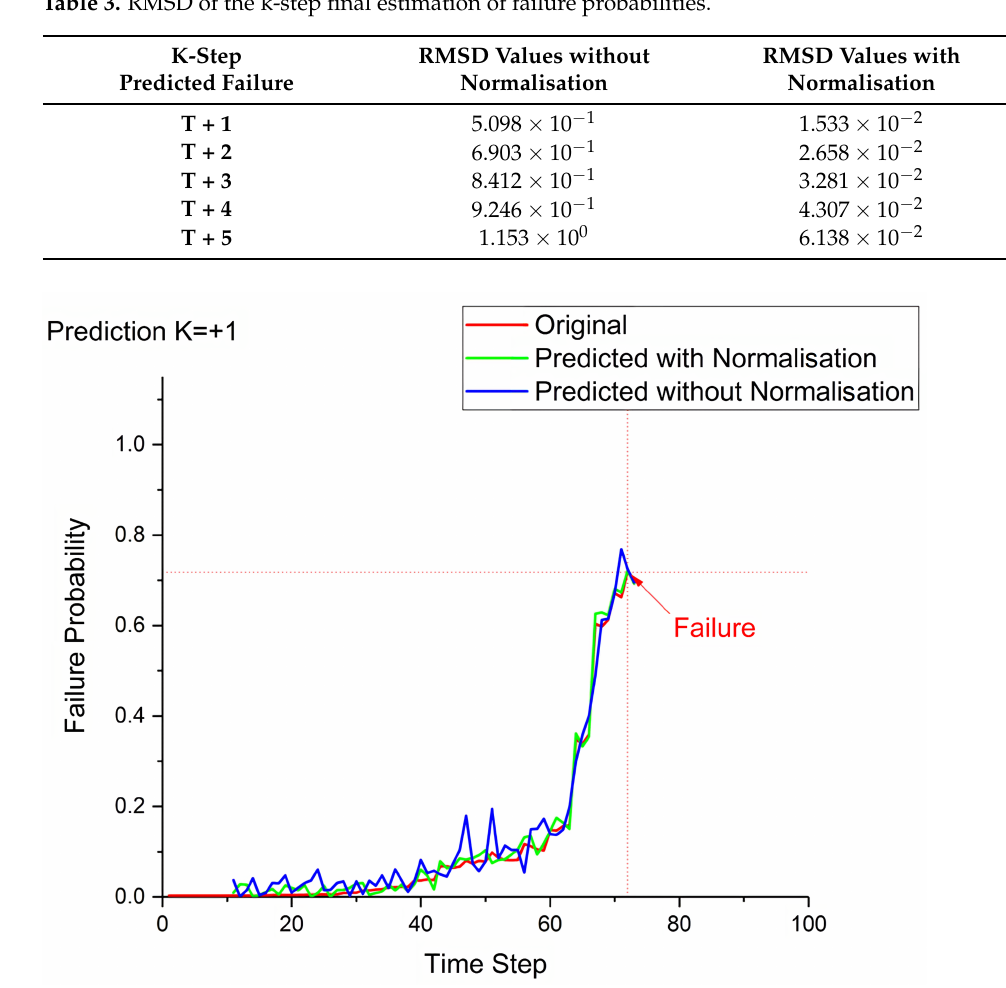
Figure 6. Failure prediction at T +